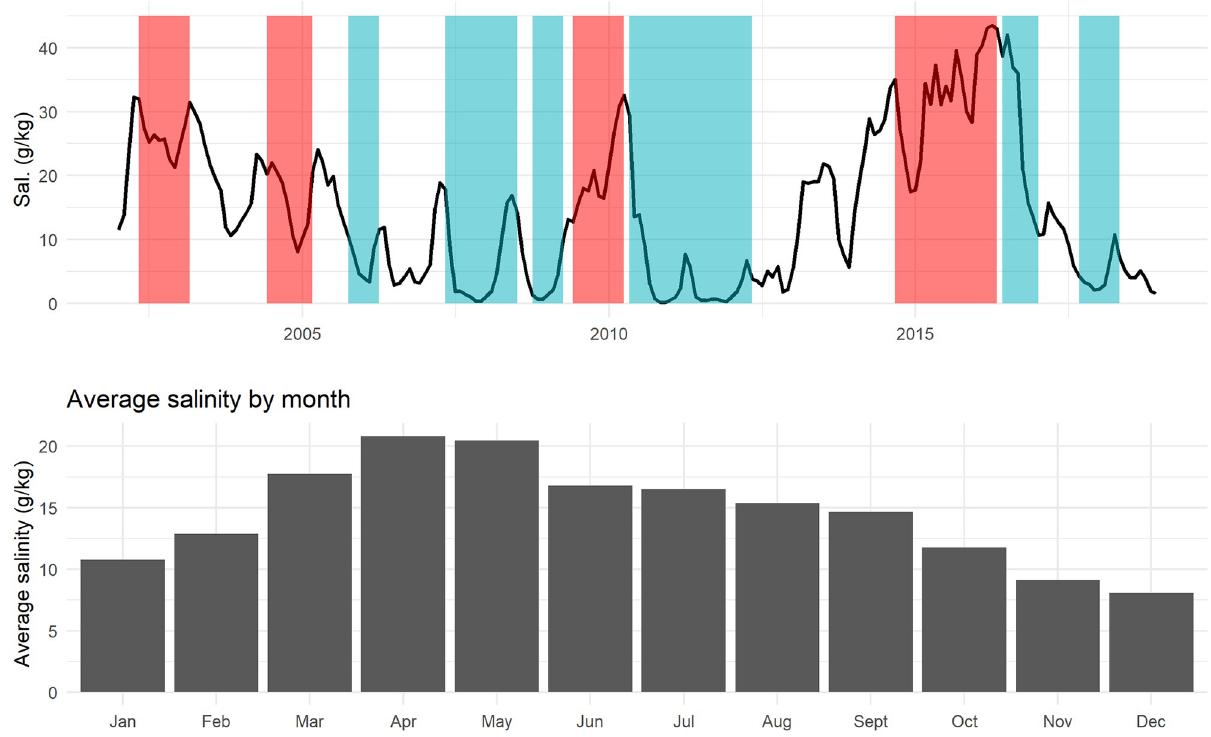
Fig 1. Salinity: Interannual and seasonal variability. Red: El Ni ñ o. Blue: La Ni ñ a.